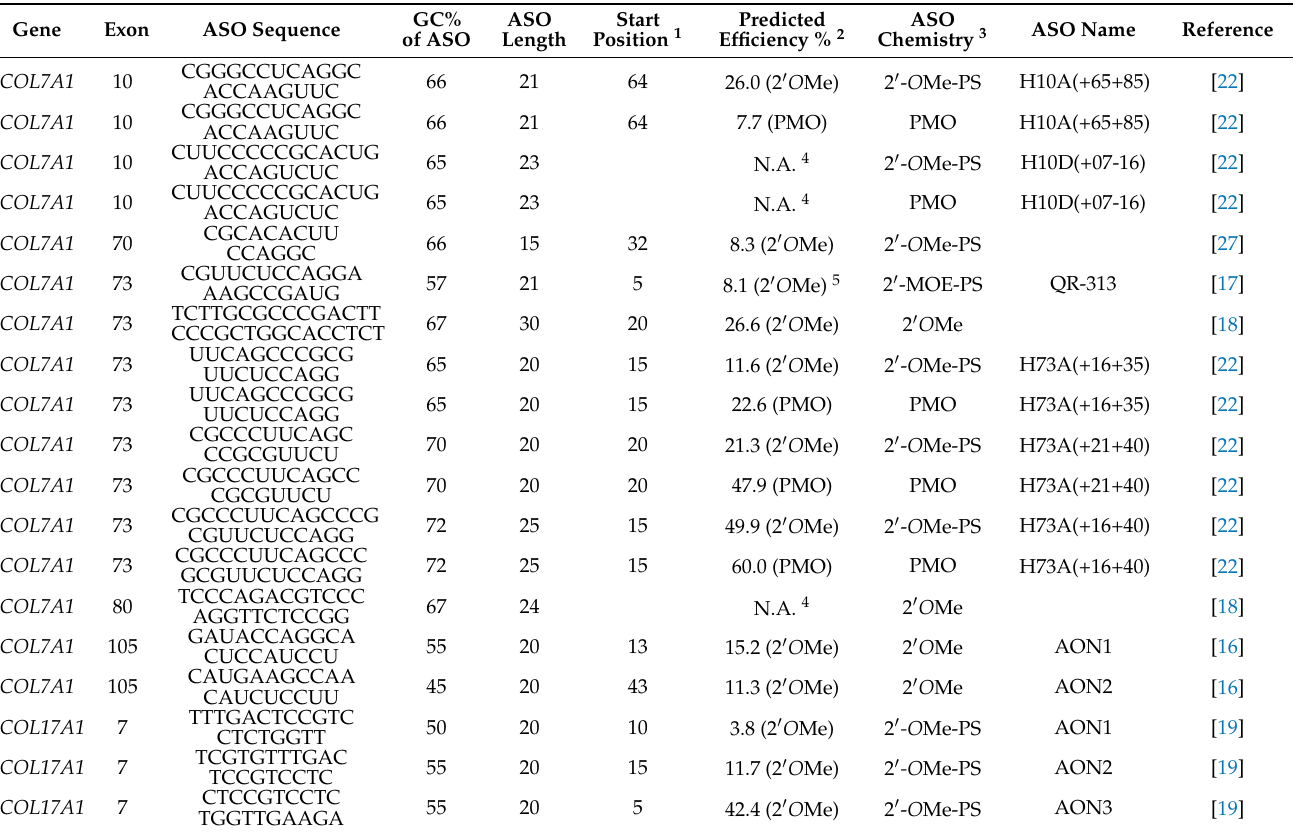
Table 2. ASOs developed to induce exon skipping in EB